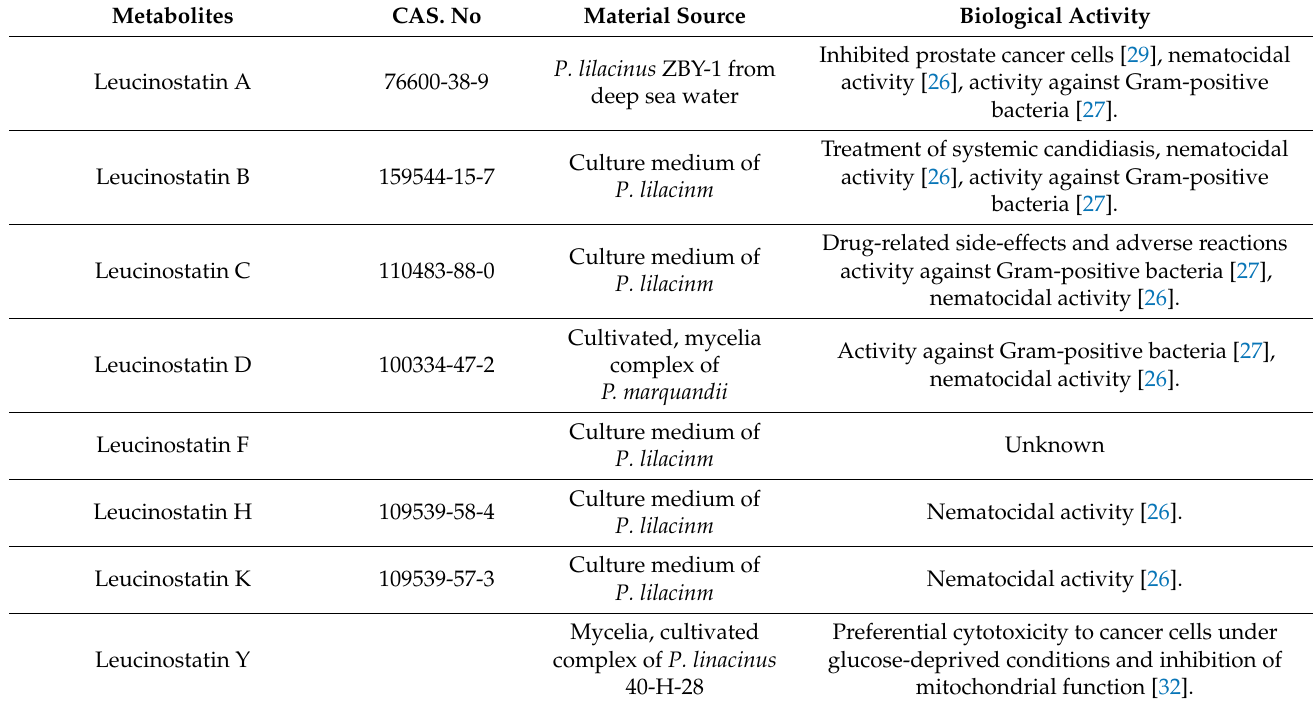
Table 1. SMs isolated from Purpureocillium lilacinum and their biological activities.